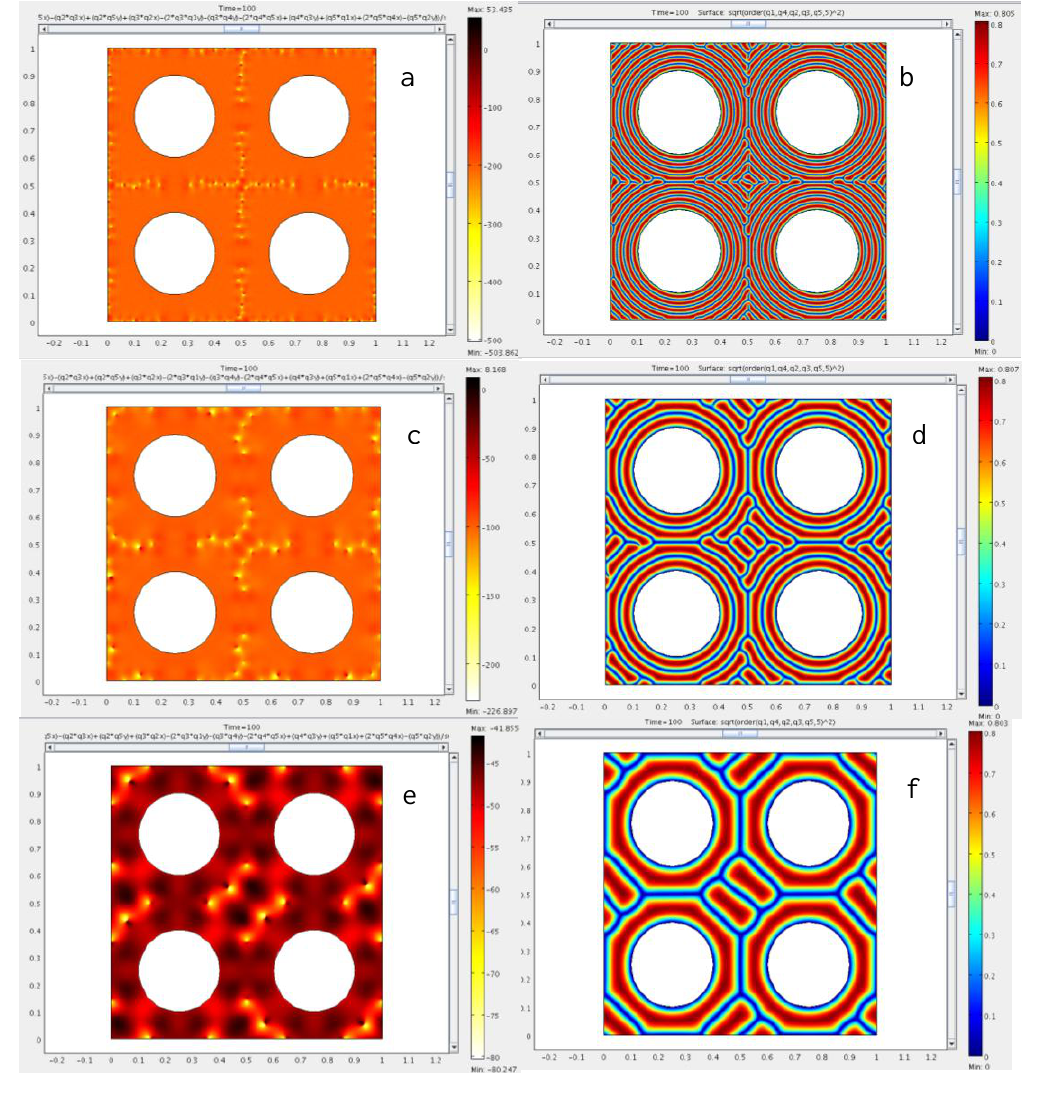
Figure 7. Simulation results for chiral nematic self assembly at t = 100, for length scales (ξ/p ) = 0.05, υ = 1and U = 6, for varying (ξ/h 0 (left) and out-of-plane component |n (b); 0.005 (c) and (d); 0.01 (e) and (f).